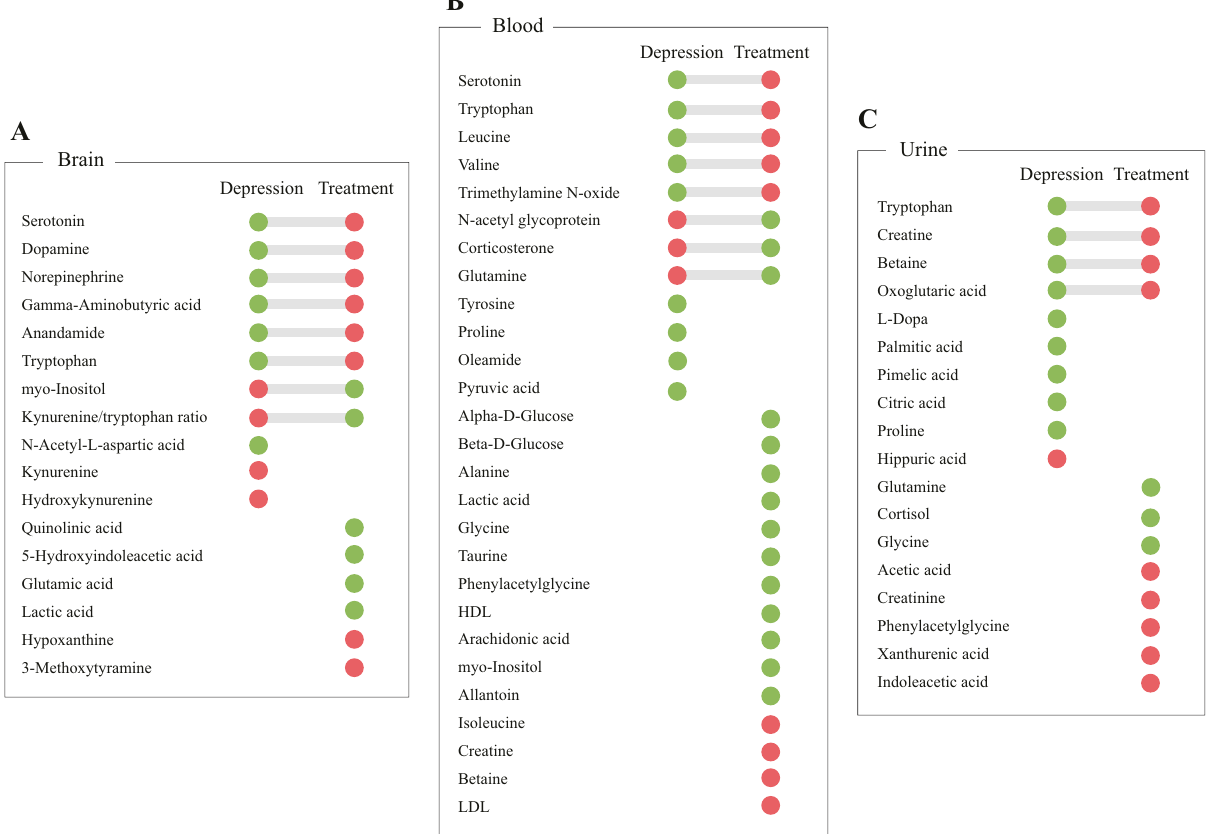
Fig. 4 Pharmacological treatment reversed metabolite disturbances induced by depression. Dysregulated metabolites in the brain ( A ), blood ( B ), and urine ( C ) resulting from both depression and pharmacological treatment. Red and green circles in the diagram indicate signi fi cant upregulation and downregulation, respectively. For each tissue, circles on the left represent dysregulated metabolites resulting from depression and the right circles represent altered metabolites caused by pharmacological